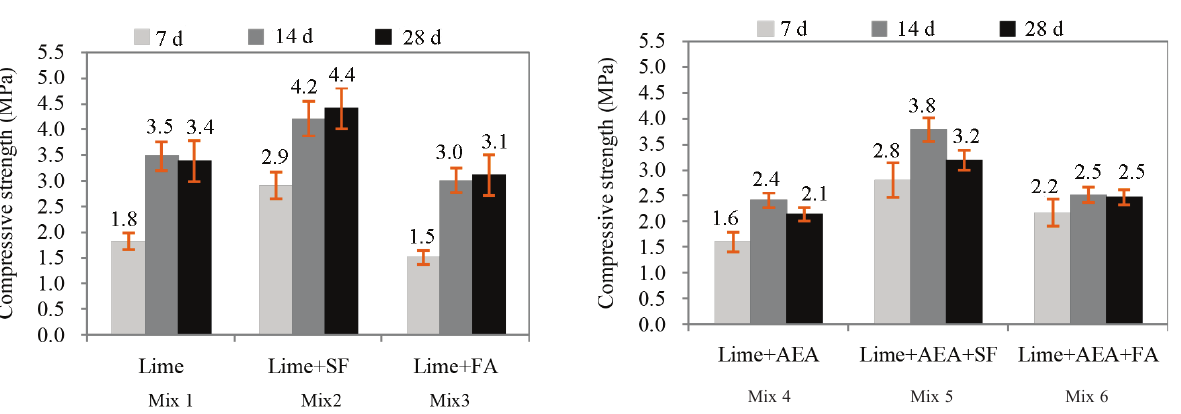
Fig. 4(b). Effect of pozzolans and SP on the compressive strength of grouts